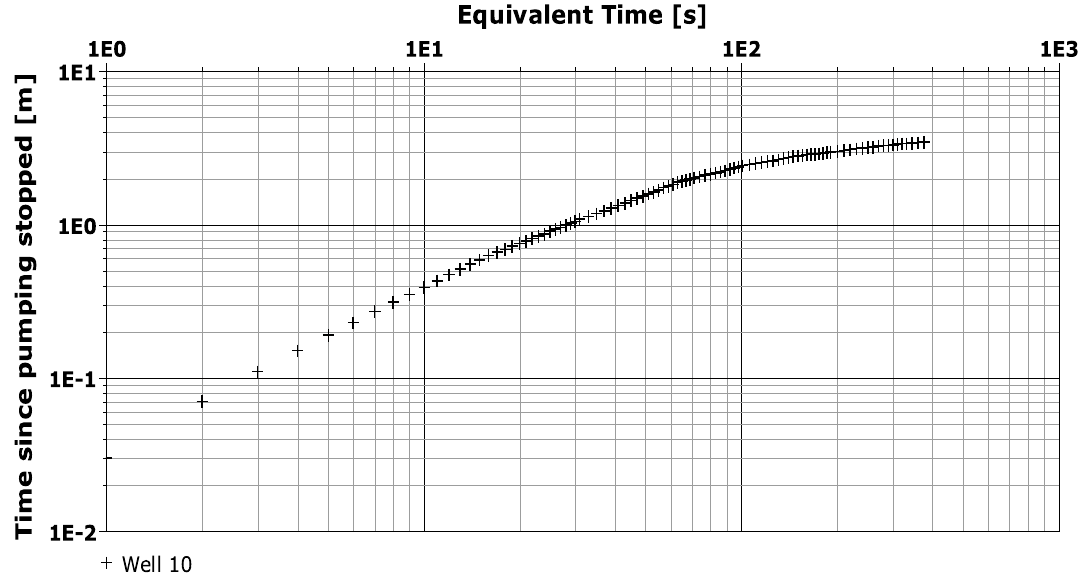
Fig. 15 Plotting of recovery rate of well-10 using aquifer mapping software